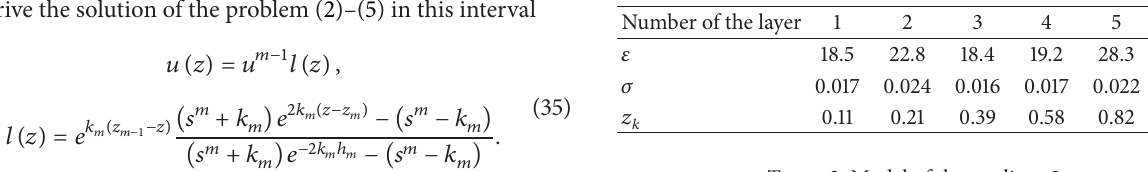
Table 1: Model of the medium 1.